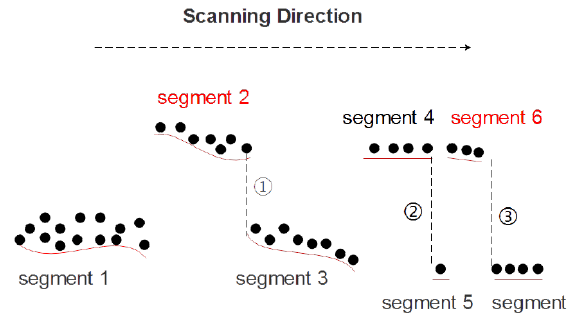
Figure 3. Ground saliency calculation